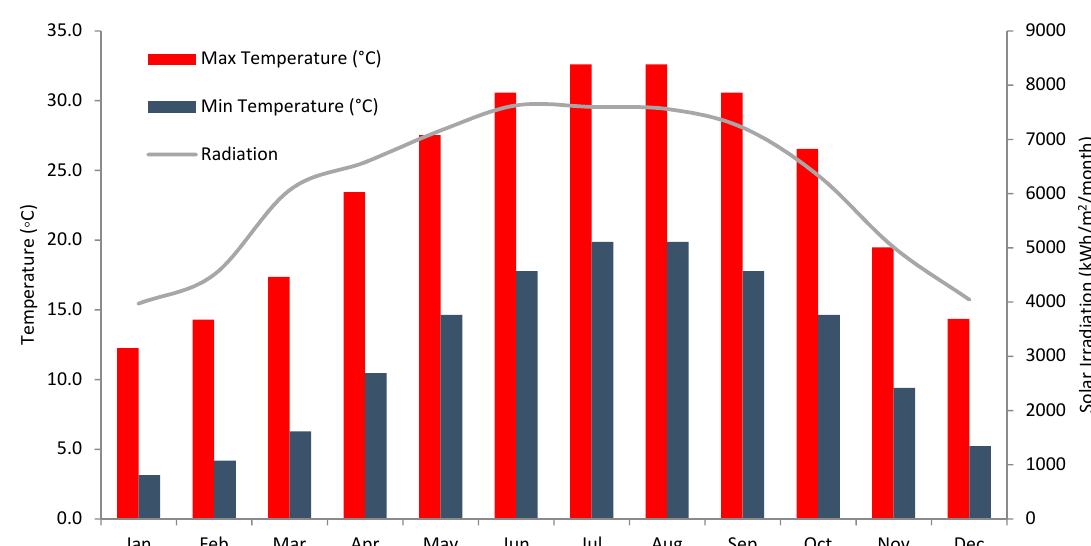
Figure 1. Maximum and minimum temperatures (°C) and solar irradiation (kWh/m 2 /month) recorded at the site.